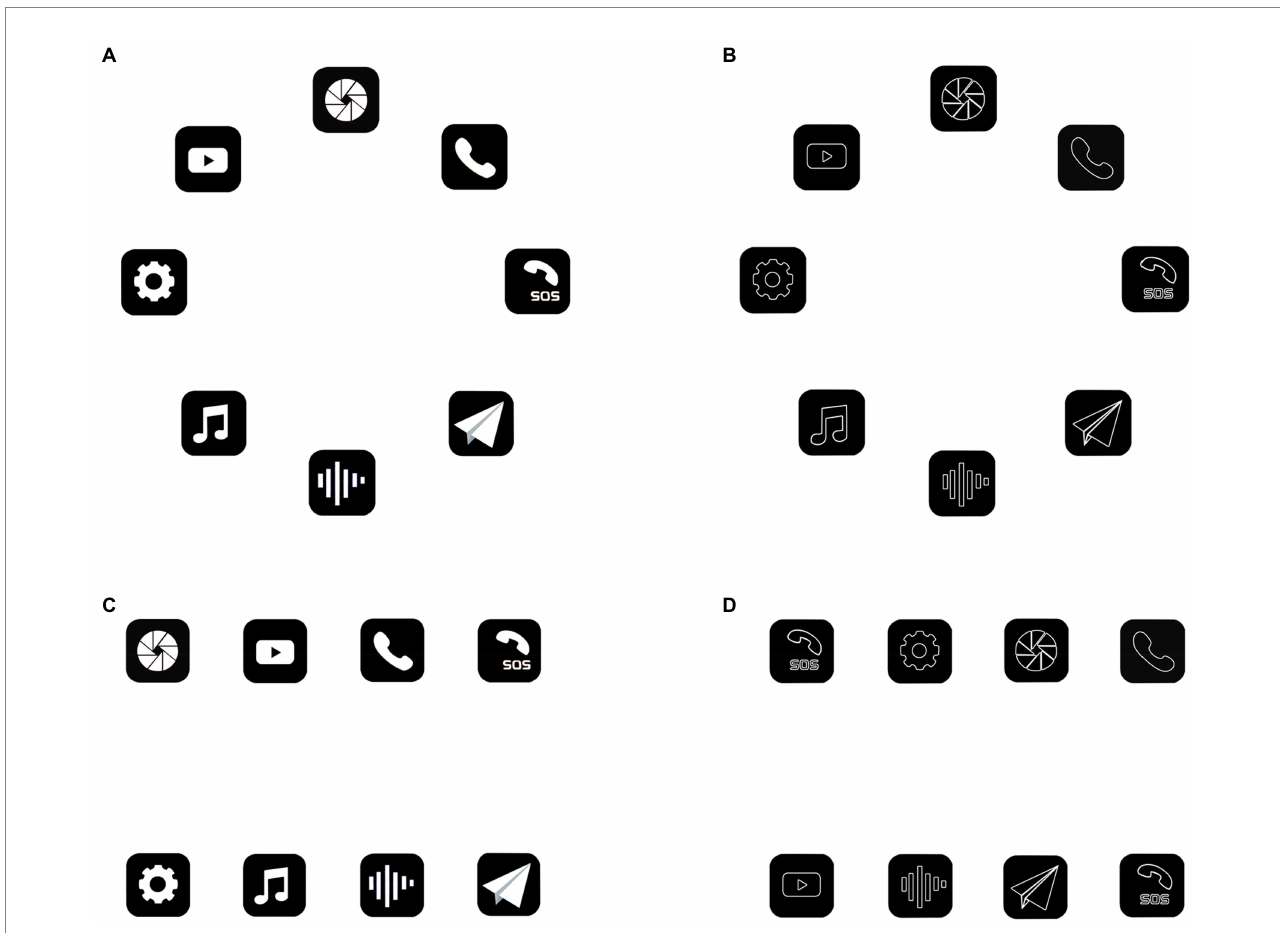
FIGURE 1 Display of icon graphic types and icon layout methods (taking Geely brand as an example). (A) Circular layout of facet icons. (B) Circular layout of linear icons. (C) Rectangular layout of facet icons. (D) Rectangular layout of linear